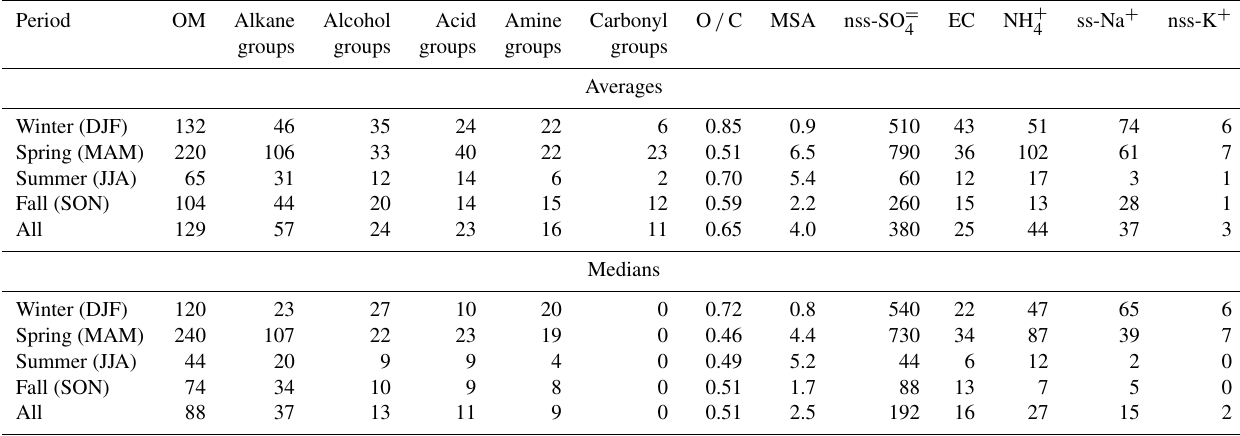
Table 1. Seasonal mass concentrations (ngm − 3 ) ; statistics based on 126 weekly concentrations ∗ . Period OM Alkane Alcohol Acid Amine Carbonyl groups groups groups groups groups Averages